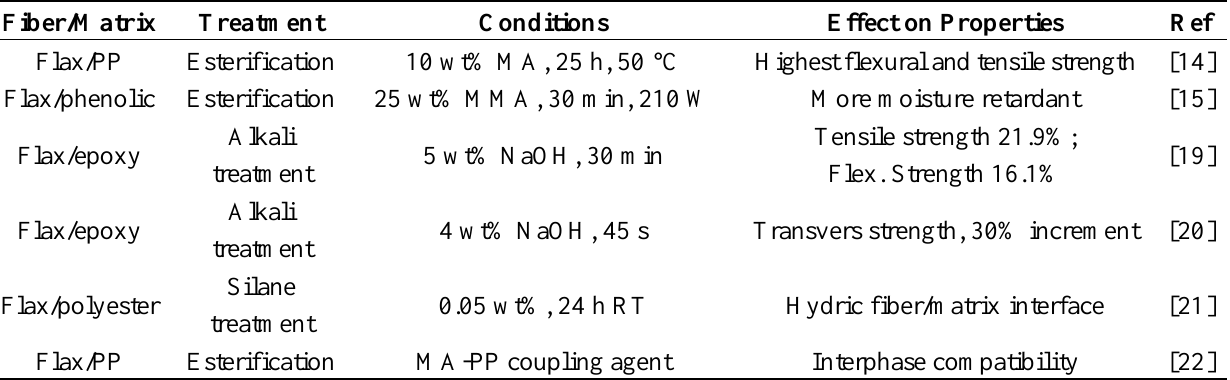
Table 2. Different treatments of flax-reinforced